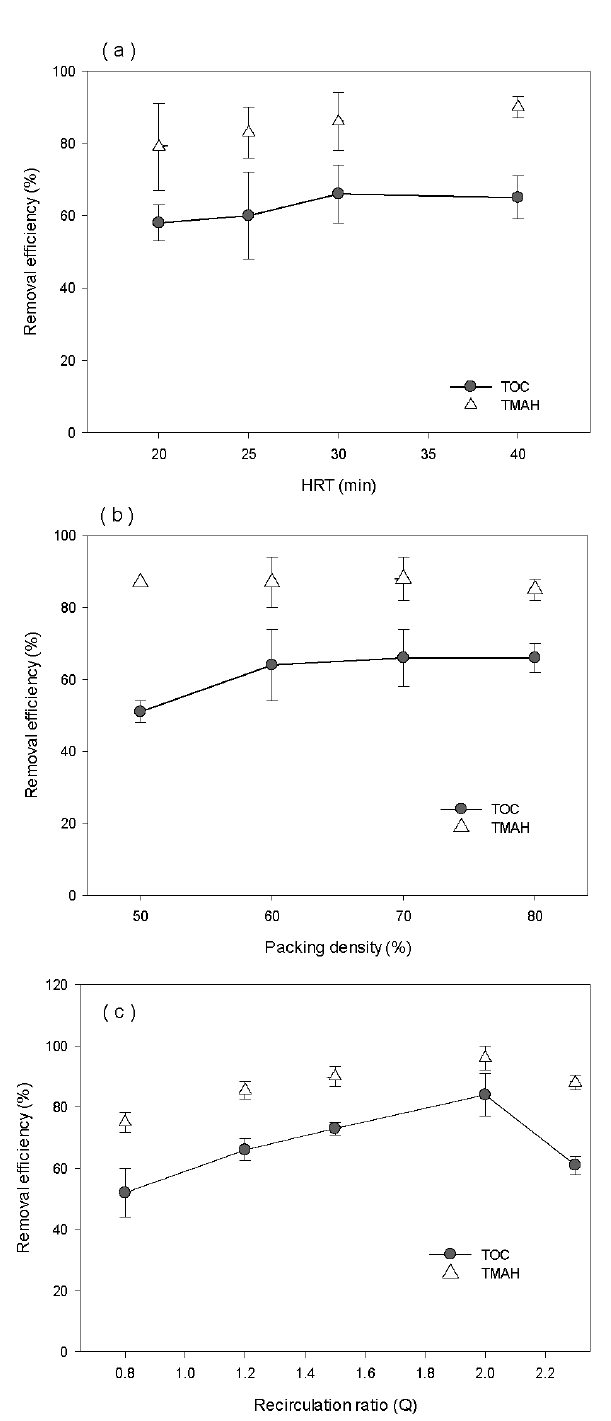
Figure 9. Removal efficiencies of TOC and TMAH in different ( a ) hydraulic retention time, ( b ) Figure 9. Removal e ffi ciencies of TOC and TMAH in di ff erent ( a ) hydraulic retention time, ( b ) packing packing density, and ( c ) recirculation ratio. density, and ( c ) recirculation